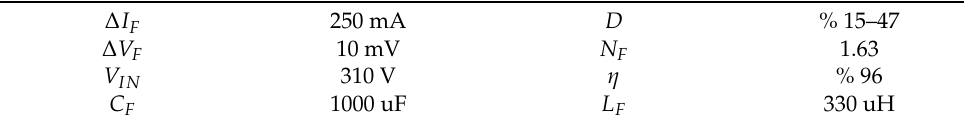
Table 2. The parameters of the forward converter.